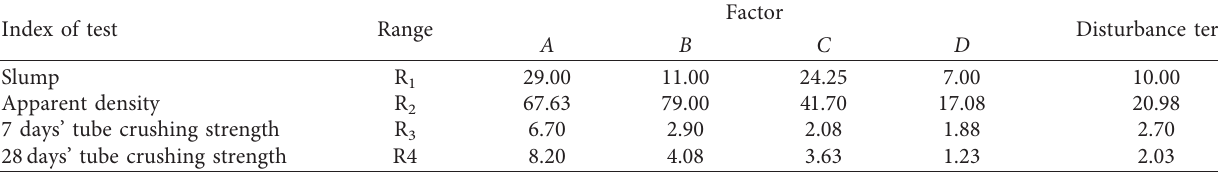
Table 10: Range analysis.